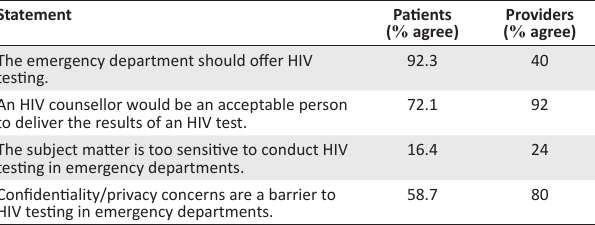
TABLE 2: Patient and provider response to key questions regarding emergency department-based testing strategy.